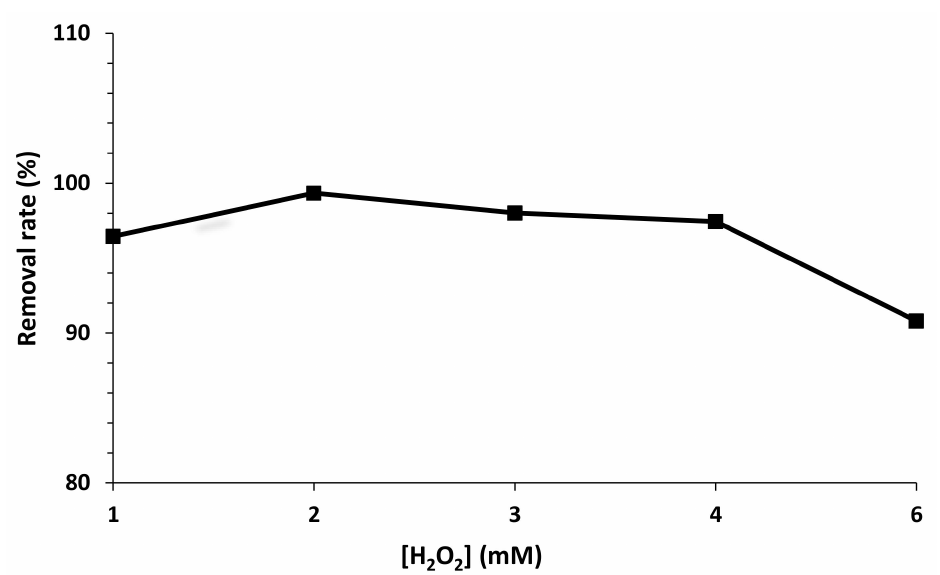
Figure 8. Effect of the H 2 O 2 concentration on Fenton’s reaction with AC-Fe. (pH = 3.5, [TBO] 0 = 50 mg/L, [AC-Fe] = 1.2 g/L, reaction temperature = 20 ◦